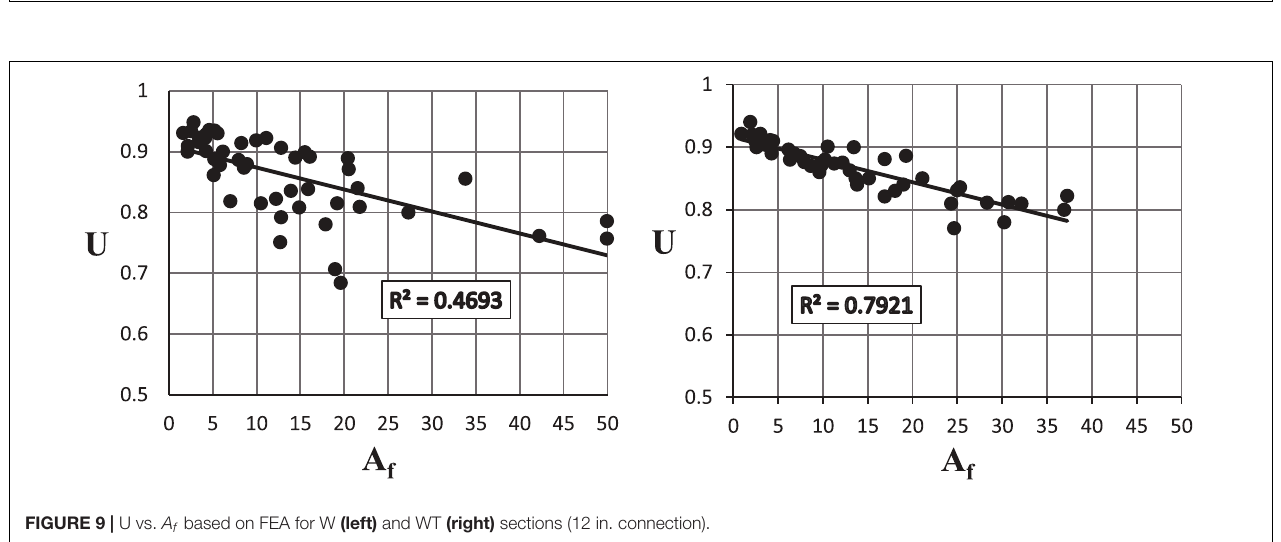
FIGURE 8 | U vs. d based on FEA for W (left) and WT (right) sections (12 in. connection).